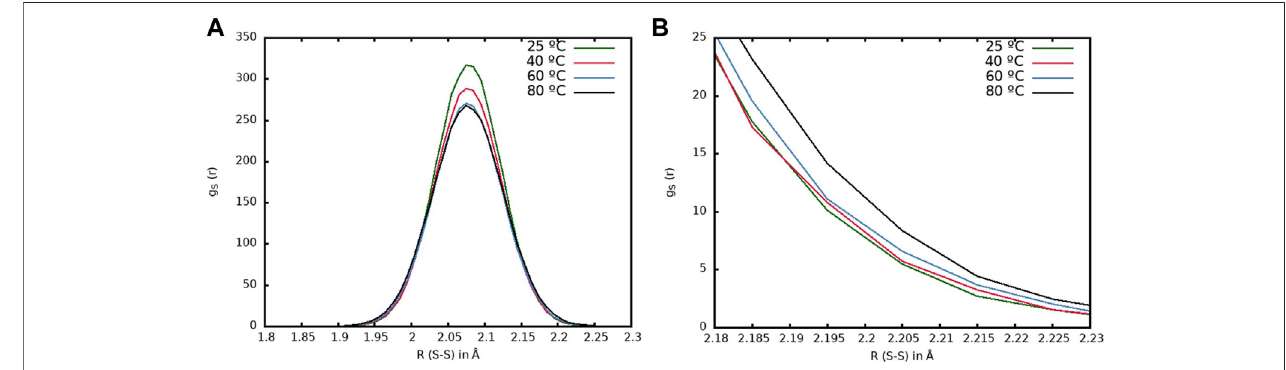
FIGURE 9 | (A) Radial distribution function corresponding to the sulfur atoms of the disul fi de bonds for the IP model at different temperatures: 25 ° C (green line), 40 ° C (red line), 60 ° C (blue line) and 80 ° C (black line). (B) Enlargement of the region between 2.16 and 2.23 Å.